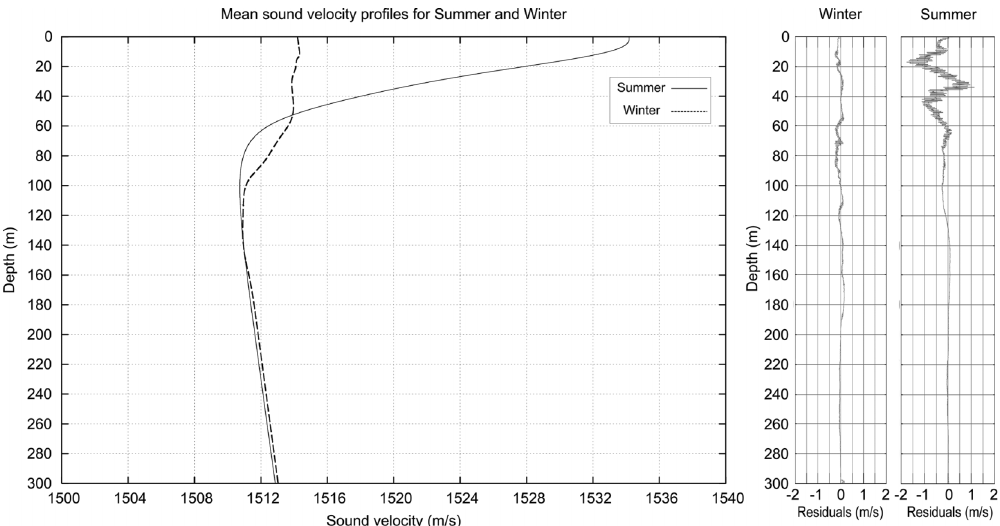
Fig. 5. Mean velocity profiles ( left ) for the summer and winter seasons calculated from eq. (2.1) and residuals ( right ) evaluated respect to the mean velocity profiles computed using the 15 velocity profiles obtained from da- ta. Below 50 m depth the residuals are lesser than 0.5 m/s for both summer and winter mean velocity